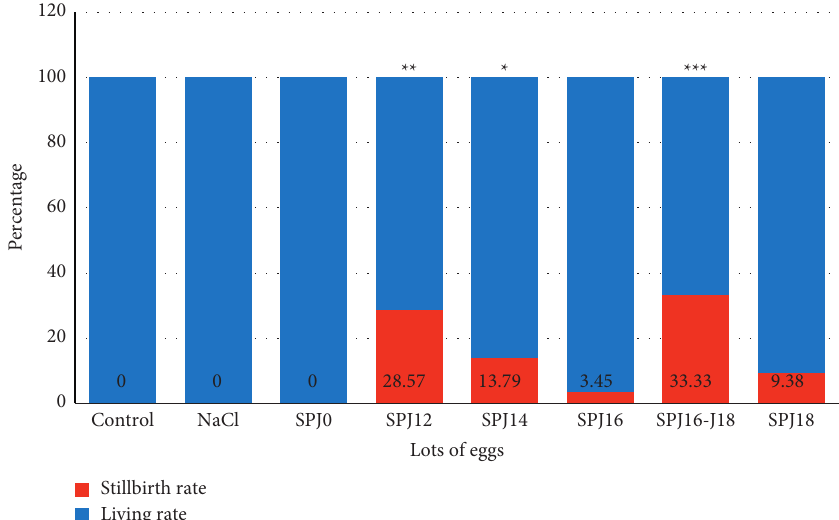
Figure 2: Stillbirth rate in the different eggs batches. Eggs were incubated under normal conditions (37.7 ° C; 55% relative humidity; 0.06% CO 2 ; 1/60 min of turning). Different treatments are made on different days. The stillborn rate was then determined. Data are expressed as mean ± standard error of the mean (SEM) and analyzed by one-way ANOVA, followed by Tukey test ( p < 0 . 05) as compared to the respective parameter value of control groups. ∗ p < 0 . 05, ∗ ∗ p < 0 . 01, ∗ ∗ ∗ p < 0 . 001, ∗ ∗ ∗ ∗ p < 0 . 0001 significant difference from control. ns � not significant. SP J0 � injection of sulfadoxine-pyrimethamine before the start of incubation; SP J12 � injection of sulfadoxine-pyri- methamine on day 12 of incubation; SP J14 � injection of sulfadoxine-pyrimethamine on day 14 of incubation; SP J16 � injection of sulfa- doxine-pyrimethamine on day 16 of incubation; SP J16-J18 � injection of sulfadoxine-pyrimethamine on day 16 and day 18 of incubation; SP J18 � injection of sulfadoxine-pyrimethamine on day 18 of